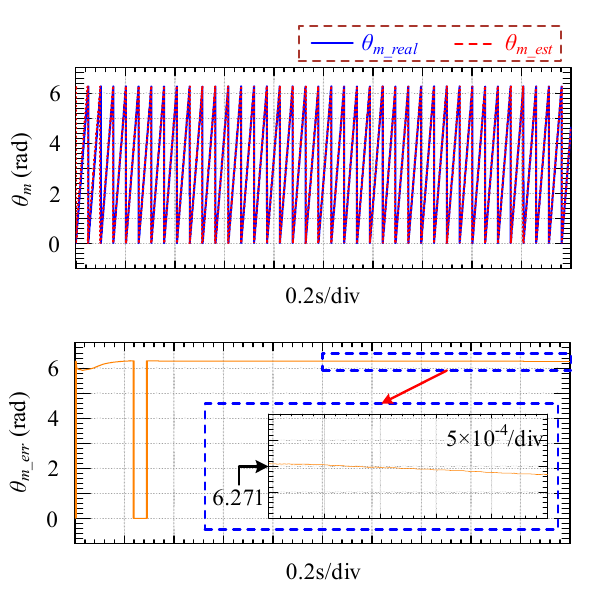
Figure 18. Real and estimated rotor positions.